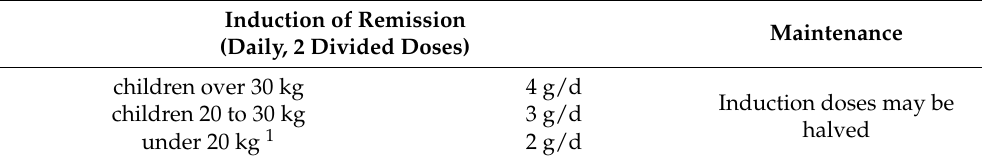
Table 2. Proposed dosage of curcumin in pediatric patients according to ECCO/ESPGHAN